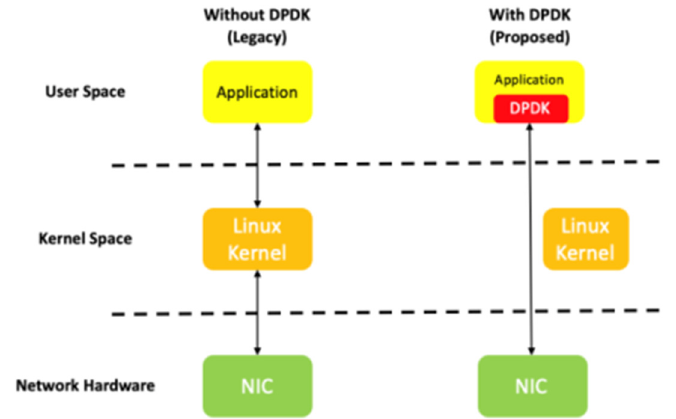
Figure 8. DPDK architecture.